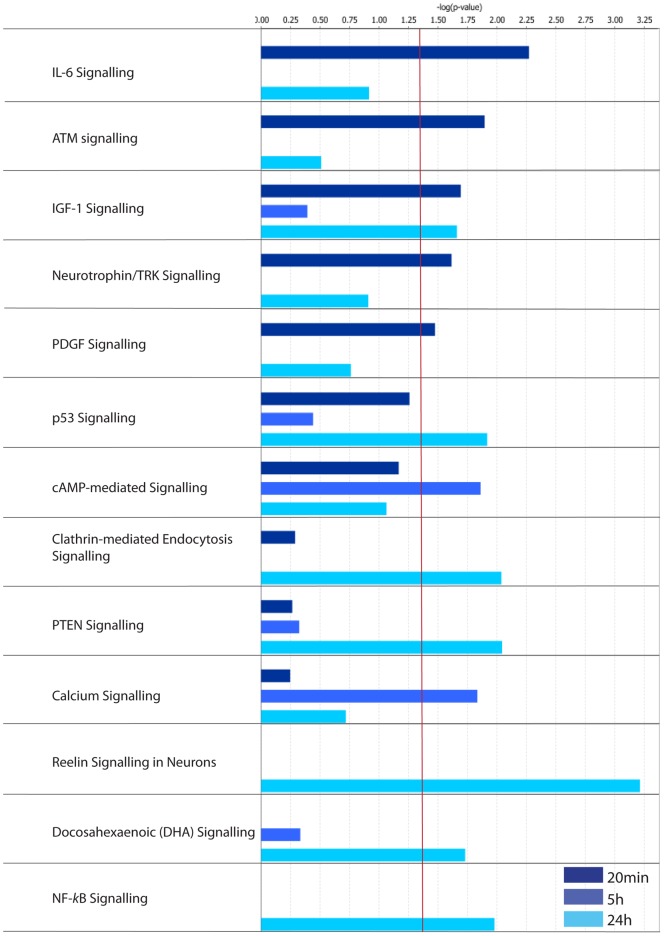
IPA Categorization of LRG sets according to their Canonical Pathways.